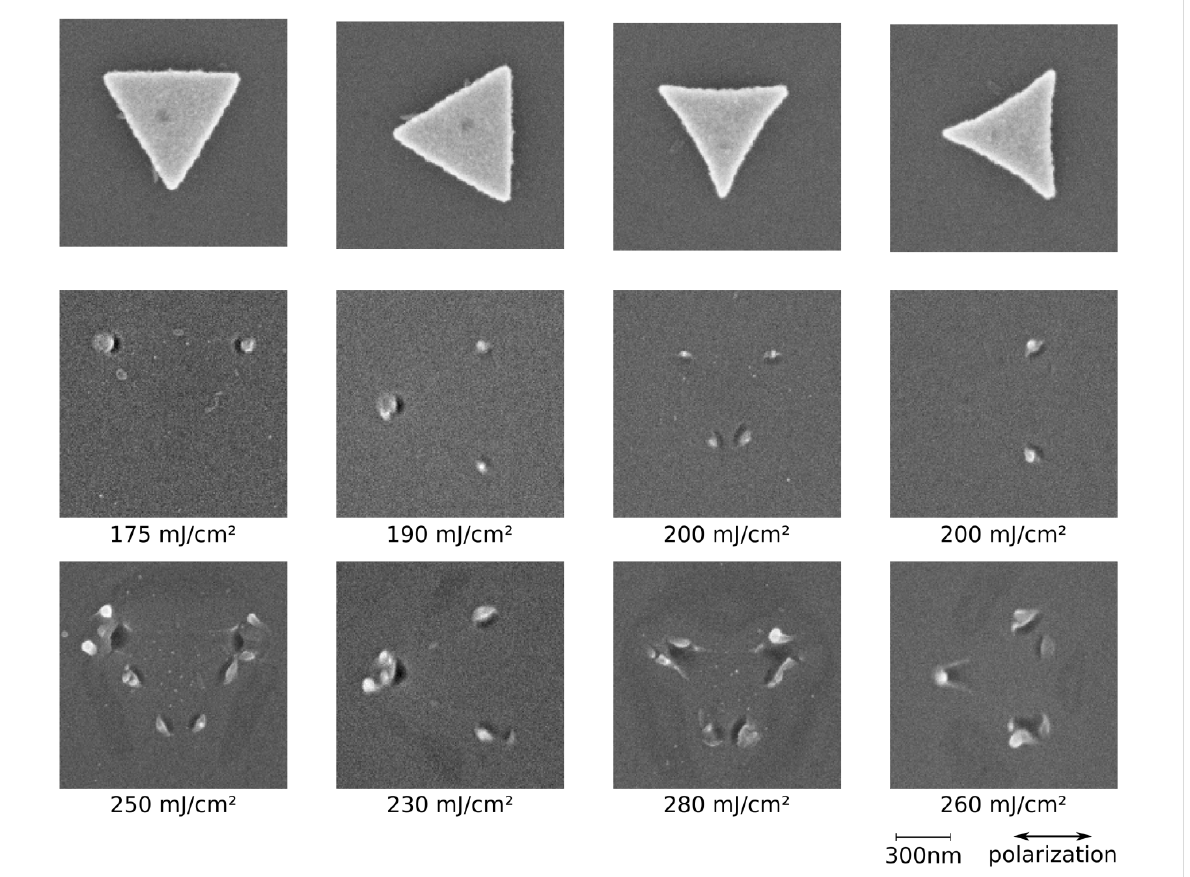
Figure 11: SEM micrographs of two different types of nanotriangles prepared by electron beam lithography, and their corresponding ablation patterns for two orientations with respect to the polarization of the incident laser light. The local fluence is indicated below each frame.